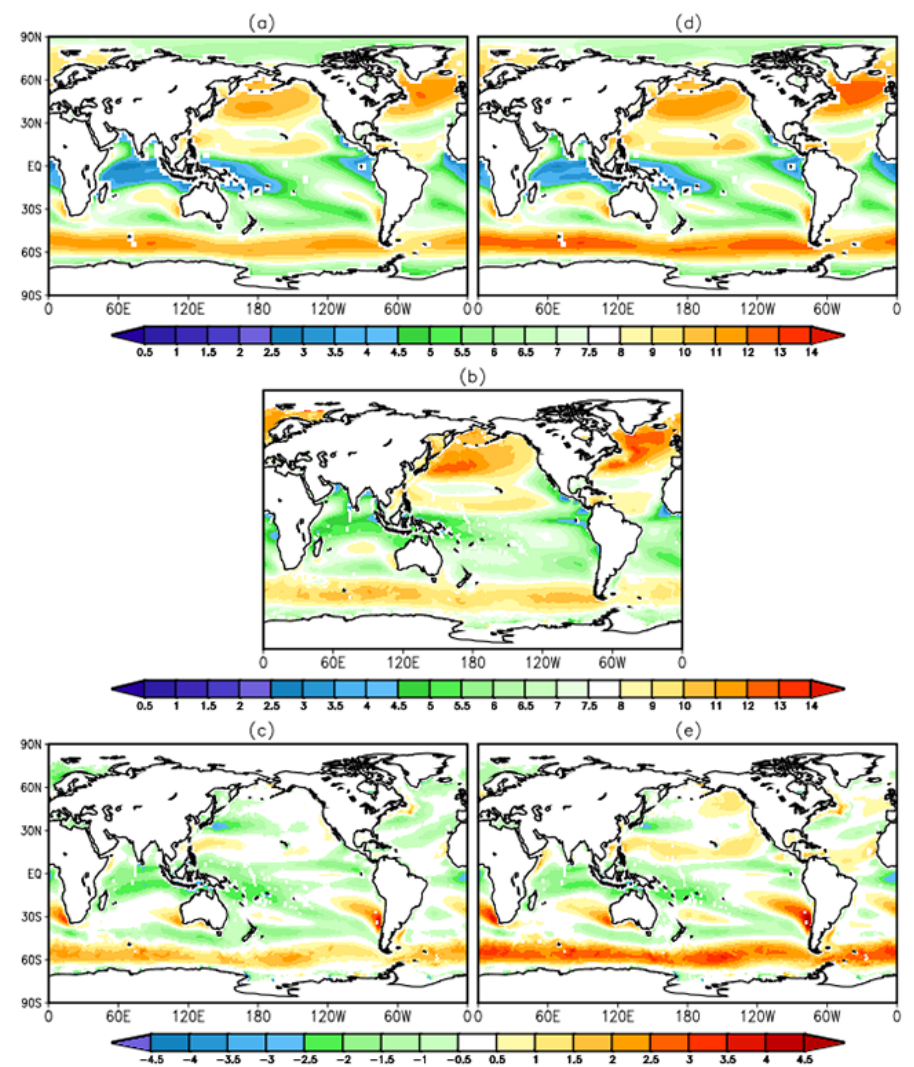
Figure 2. A 30-year average December-January-February surface wind speed (ms − 1 ) from (a) MERRA2 control, (b) GSSTF, (c) control- GSSTF, (d) experiment 1, (e) experiment